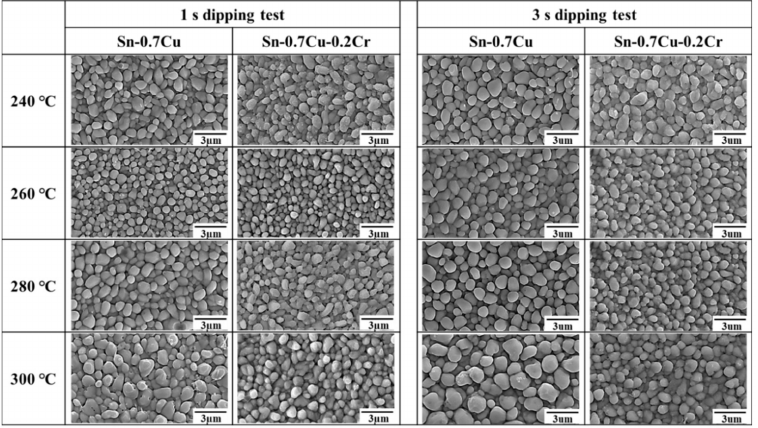
Figure 7. Top view images of the Cu 6 Sn 5 IMCs at various reaction temperatures at Sn-0.7Cu/Cu and Sn- 0.7Cu-0.2Cr/Cu solders.